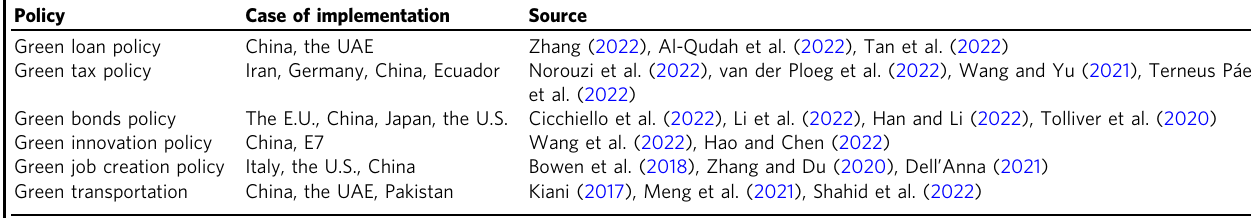
Table 1 Countries ’ policies to combat the climate change